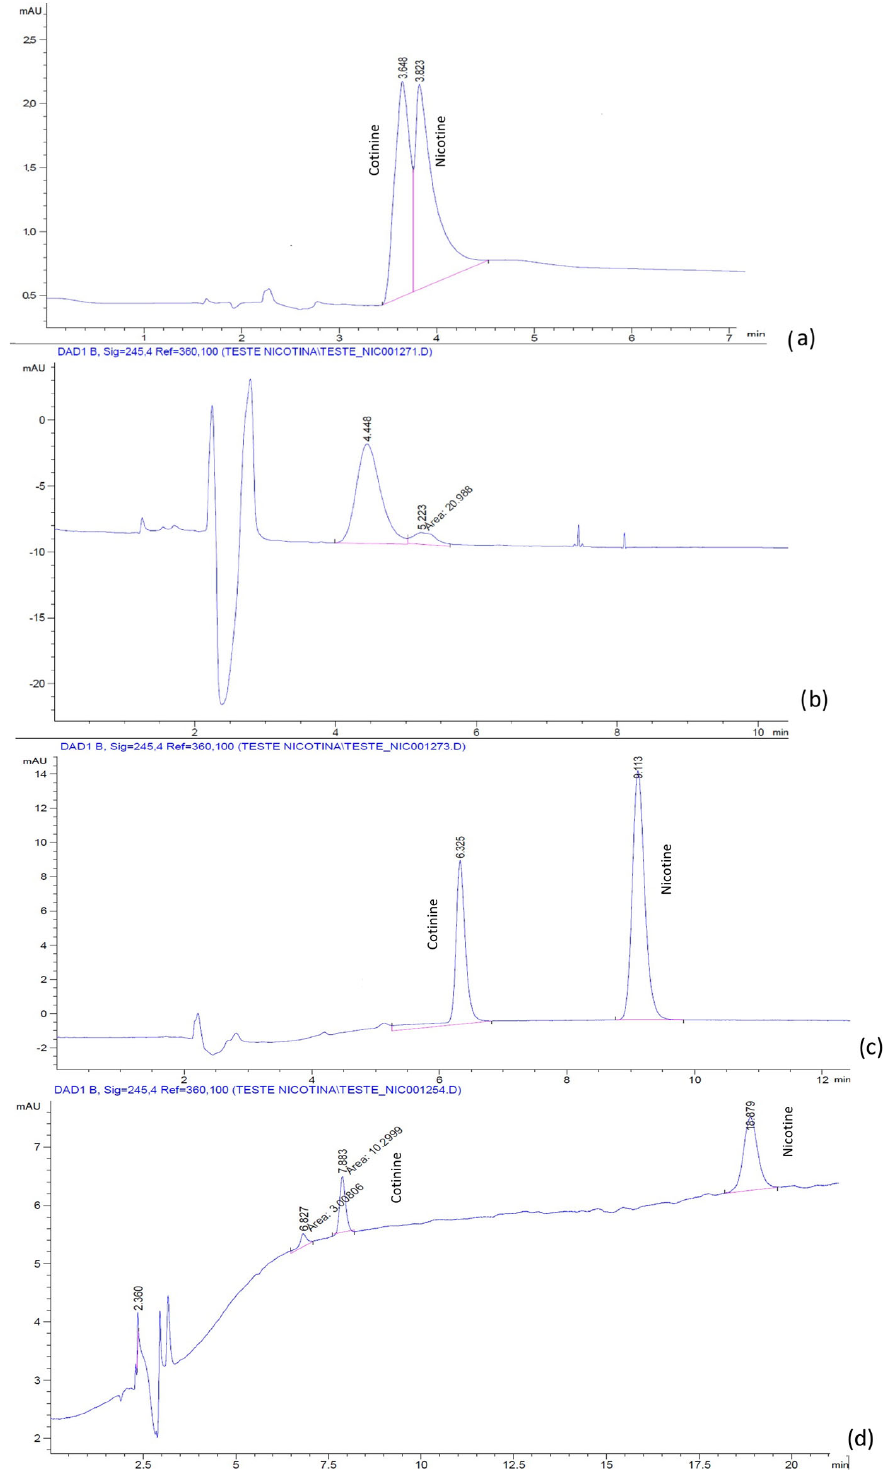
Figure 2. Chromatograms of nicotine and cotinine in human plasma with mobile phases containing H 2 O:ACN 60:40 (pH 2.5 with H 3 PO 4 ): ( a ) without additive; ( b ) with 0.5 mM BMIM[PF 6 ]; ( c ) with 1.0 mM BMIM[PF 6 ]; ( d ) with 2.5 mM BMIM[PF 6